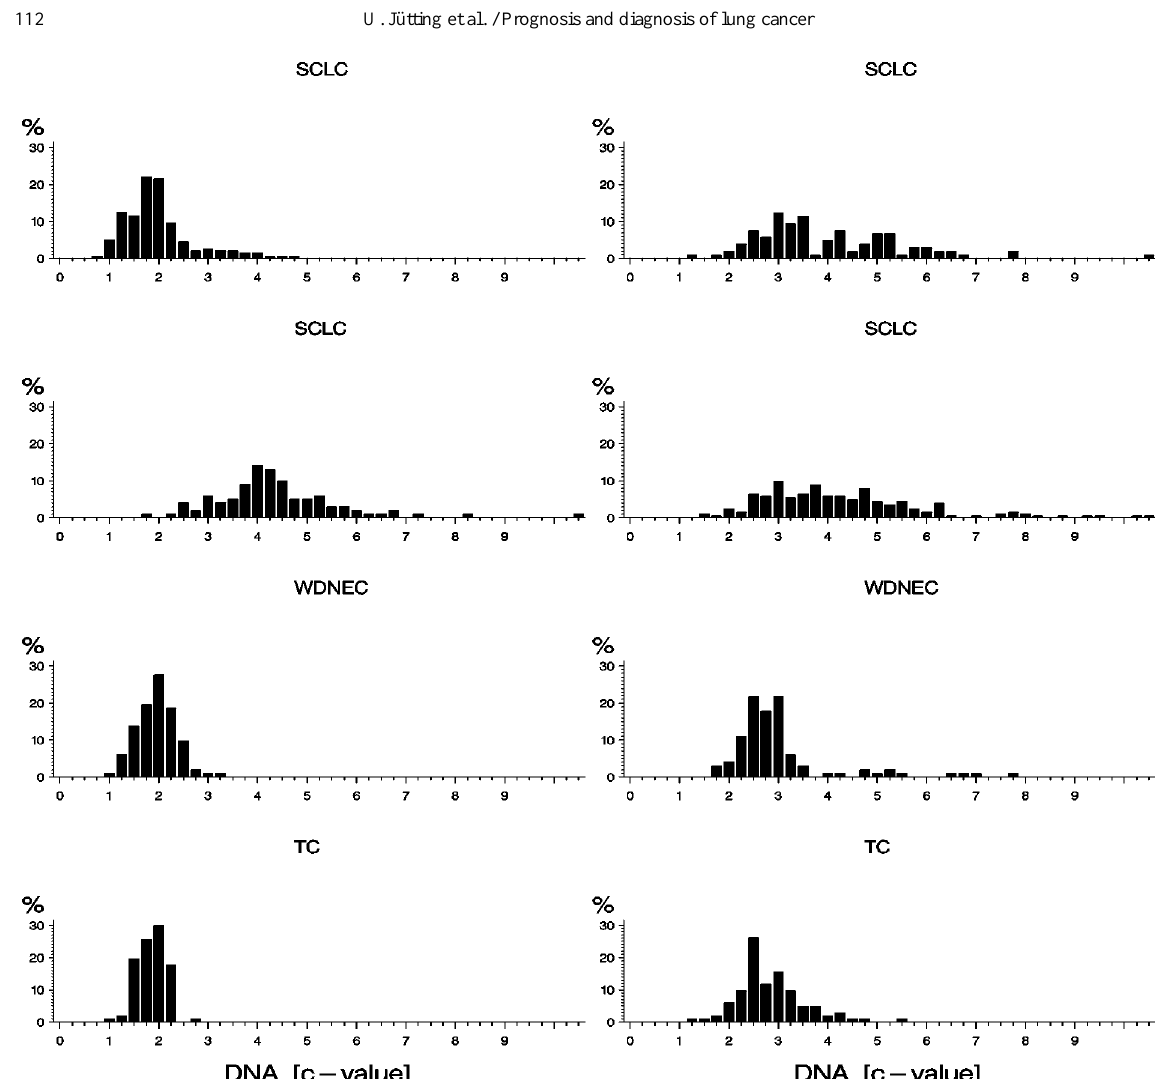
Fig. 1. Examples of typical DNA-distributions for the 3 different classes SCLC, WDNEC and